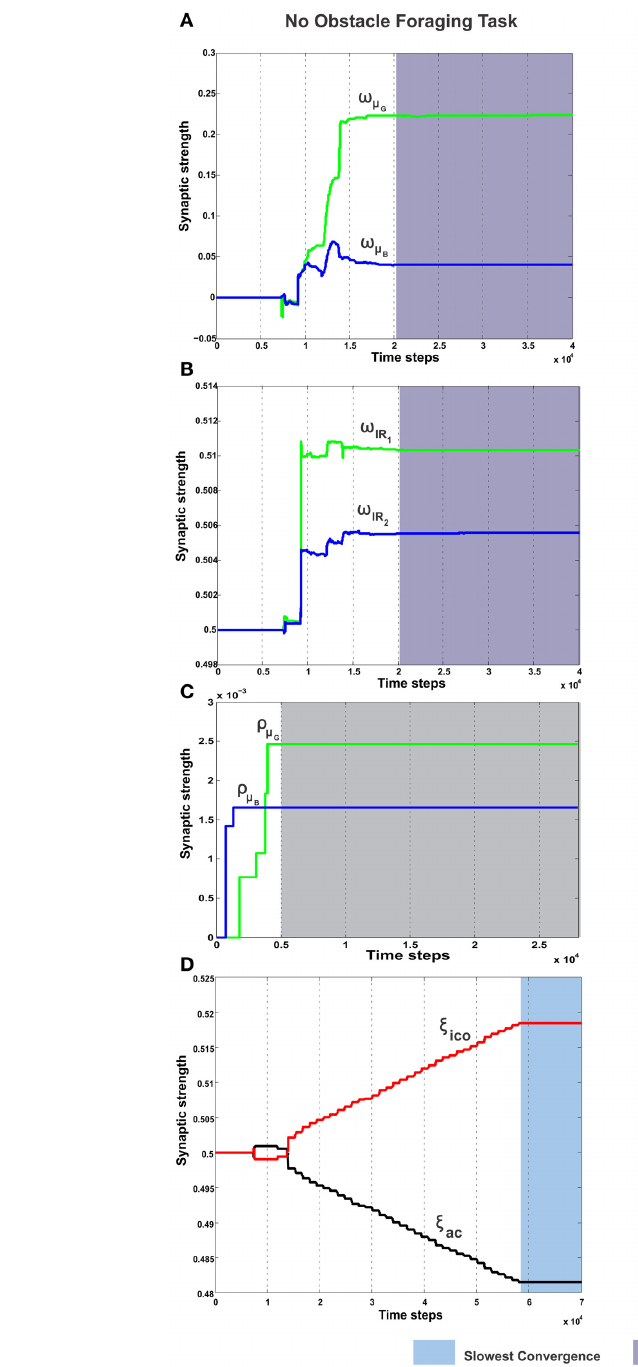
FIGURE 8 | Synaptic weight change curves for the static foraging tasks toward blue. (D) Learning curve of the RMHP combined learning mechanism without obstacle and with single obstacle. (A) Change in the synaptic showing the change in the weights of the ICO network output (depicted in corresponds to the input weights weights for actor-critic RL learner. Here w μ red). ξ ico is weight of the ICO network output. ξ ac is weight of the actor-critic G corresponds to the of the orientation sensor toward the green goal and w μ RL network output (depicted in black). (E–H) Show the change in the weights B input weights of the orientation sensor toward the blue goal. (B) Change in corresponding to the single obstacle static foraging task. In all the plots the is the left IR the weights of the two infrared sensor inputs of the actor. w IR gray shaded region marks the region of convergence for the respective 1 is the right IR sensor weights. (C) Change in the synaptic sensor weight, w IR synaptic weights. Three different timescales exist in the system, with the 2 is the CS stimulus weight for the orientation weights of the ICO learner. ρ μ ICO learning being the fastest, actor-critic RL being intermediate and the G sensor toward green, ρ μ the CS stimulus weight for the orientation sensor adaptive combined learning being the slowest. (see text for more B